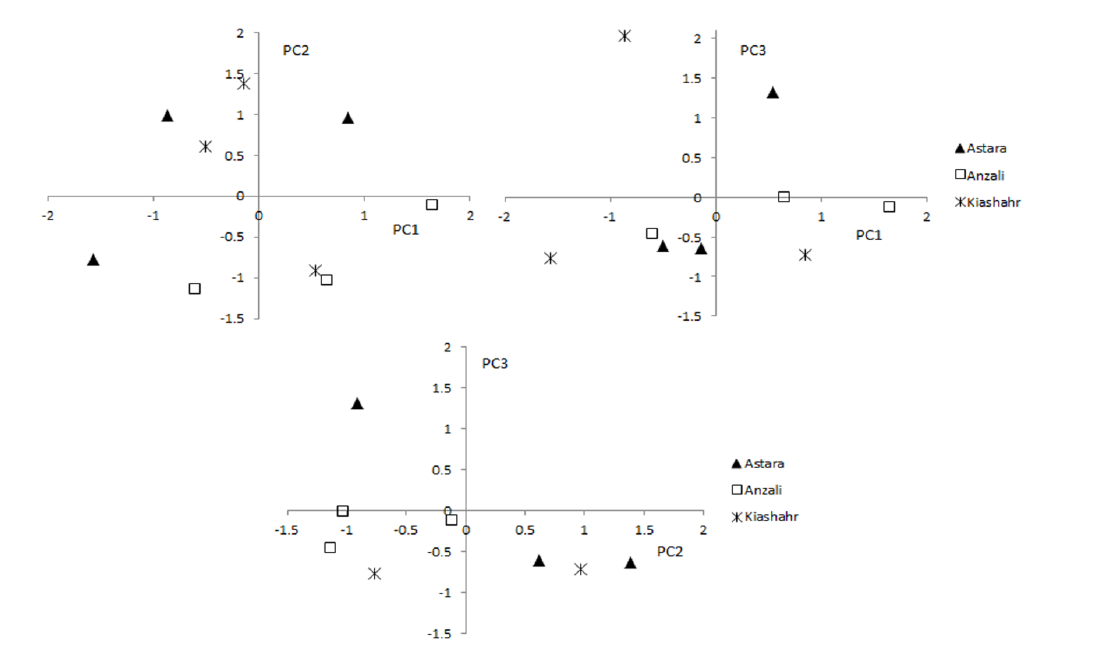
Figure 2. Principal C omponent Analysis (PCA) of the concentrations of trace elements in the fish skin in different stations of the southern coasts of the Caspian Sea. The scatter plots show individual fish scores for PC1 vs. PC2 (A), PC1 vs. PC3 (B), and PC2 vs. PC3 (C), which explain the total variance of 67.03%.